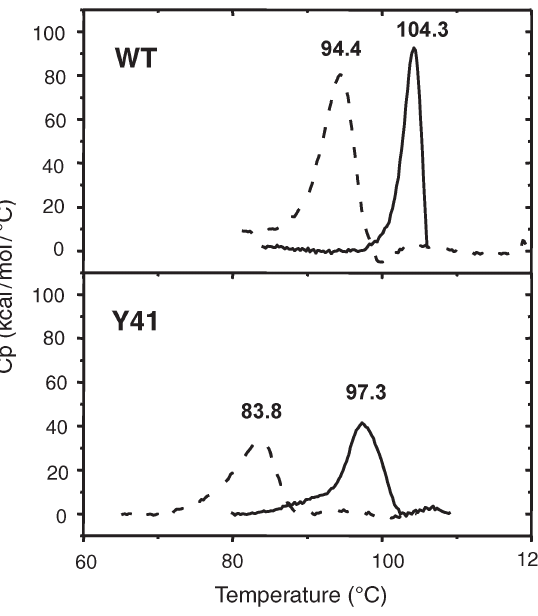
Figure 5. Differential scanning calorimetry thermograms of wild type (wt) amidase and its Y41C mutant at different pH values. Solid lines correspondto tracesobtainedin 20 mM citratebuffer at pH 4.0, dotted lines to those obtained in 20 mM sodium phosphate at pH 8.0. The concentration was always expressed as moles of dimer. Denaturation temperatures ( T m ) are indicated above the corresponding